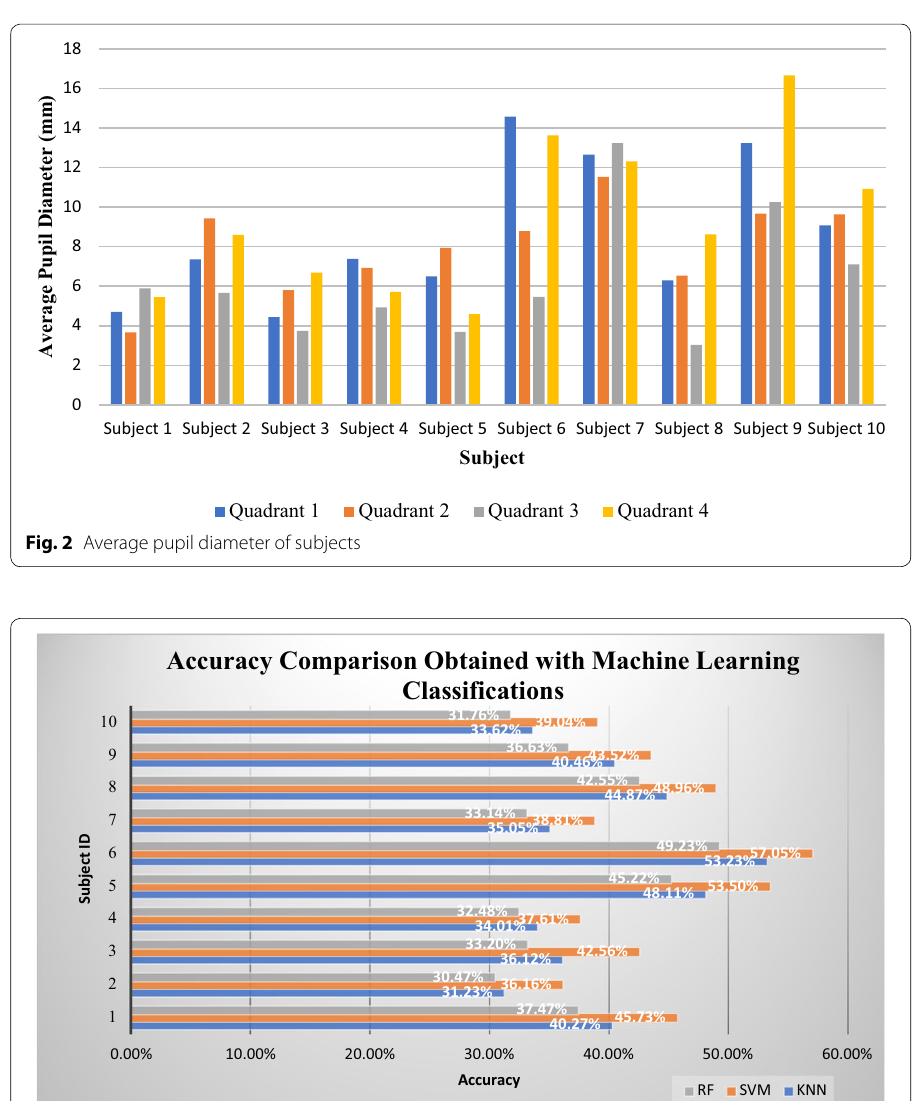
Fig. 3 The classification results using pupil diameter with machine learning